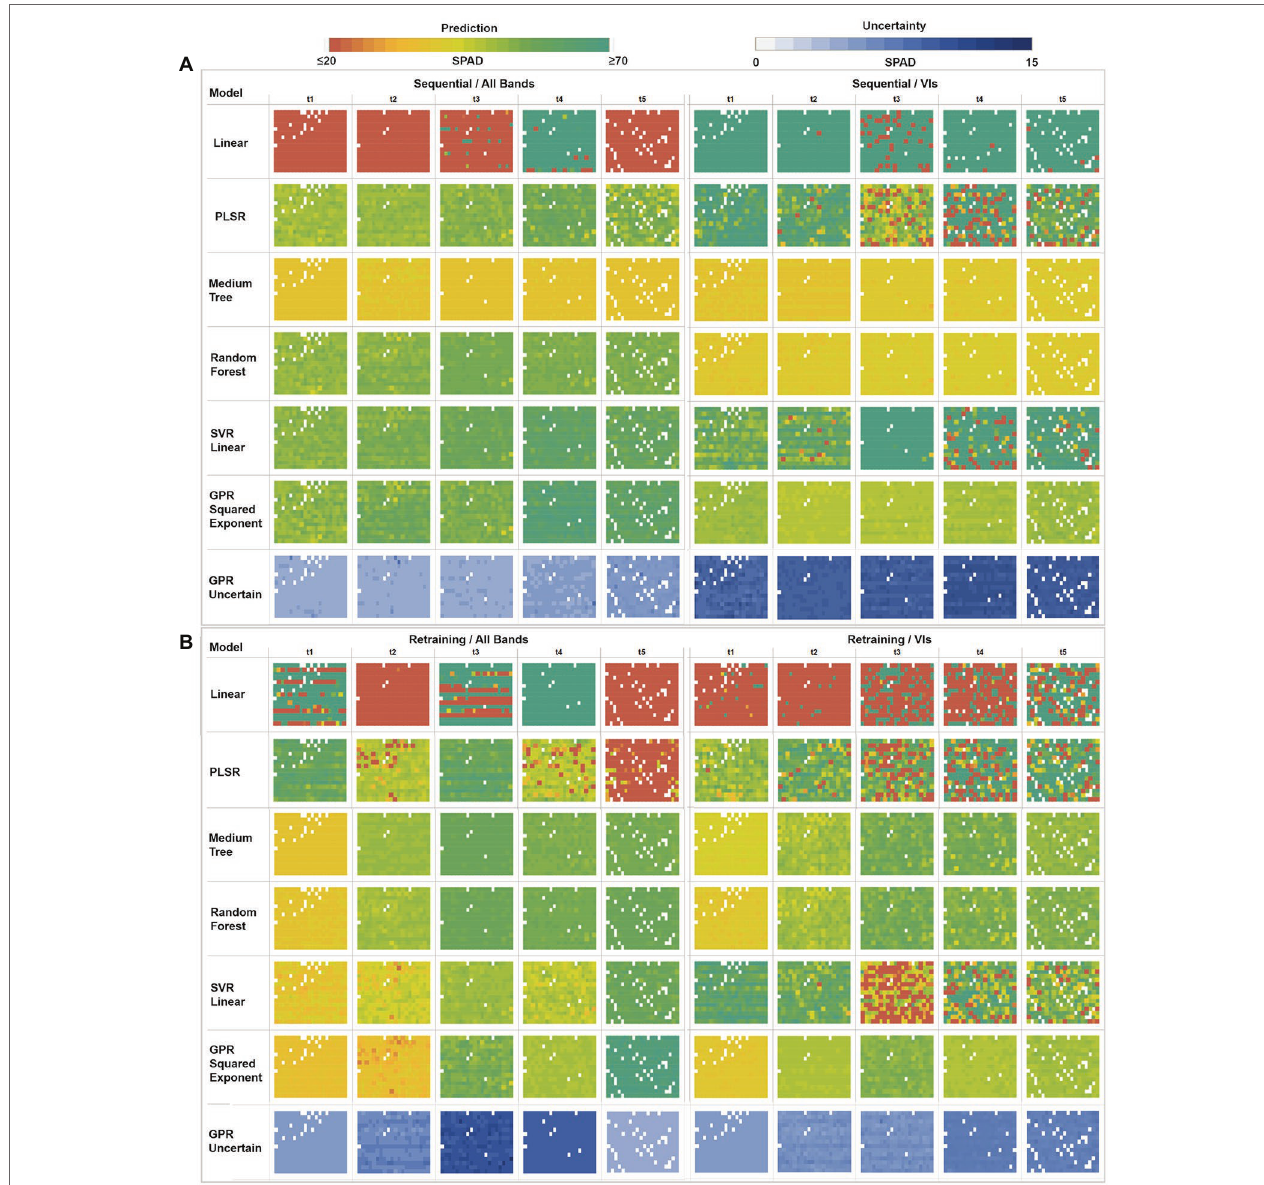
FIGURE 7 | Multi-model comparison of averaged SPAD predictions and GPR uncertainties at a plant level. (A) Sequential strategy results using All Bands versus VIs. (B) Retraining strategy results using All Bands versus VIs. Each box comprises a matrix of cells representing the mean predicted SPAD per plant, following the field sowing arrangement (rows ×